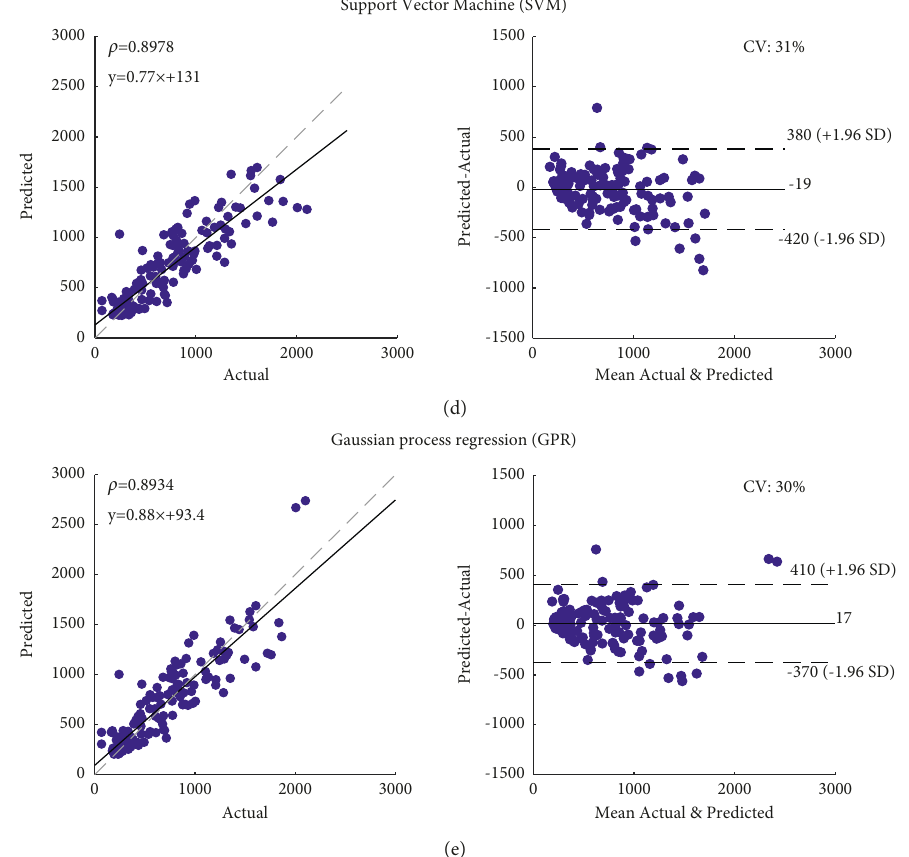
Figure 6: Correlation and Bland–Altman plots evaluated from (a) GB, (b) Bagging, (c) ANN, (d) SVM, and (e)